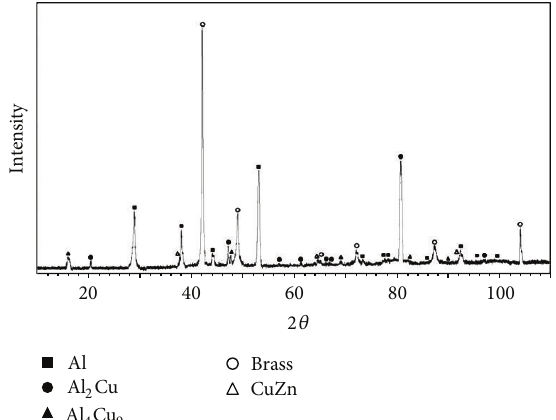
Figure 4: X-ray diffraction analysis of the weld zone.